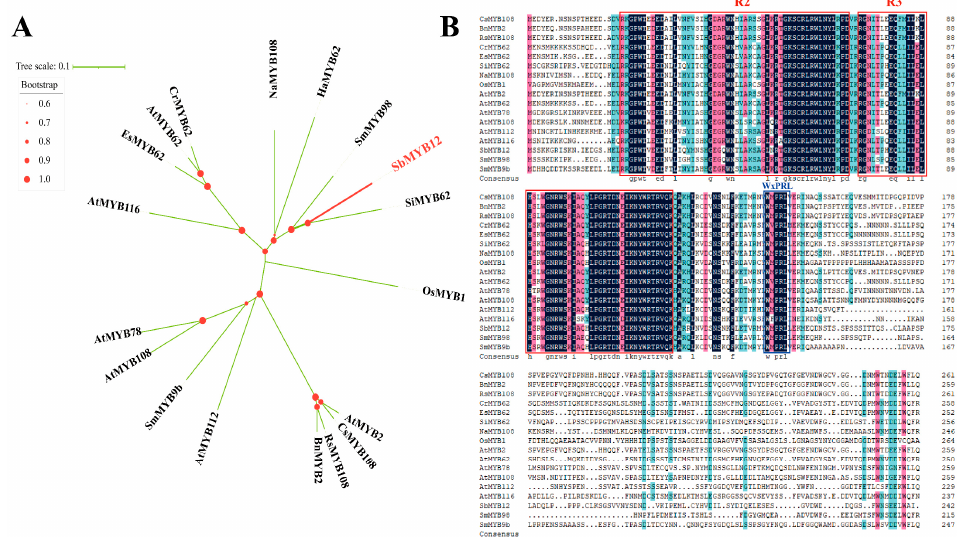
Figure 3. Analysis of Sb MYB12 compared with related sequences. ( A ) Sb MYB12 gene phylogenetic analysis along with 17 representatives of the R2R3-MYB S20 subgroup. ( B ) Analysis of sequence alignments between Sb MYB12 and other R2R3-MYB S20 subgroup proteins from different plants. Red frames indicate conserved R2 and R3 domains, and blue frames indicate the WxPRL core se- quence.